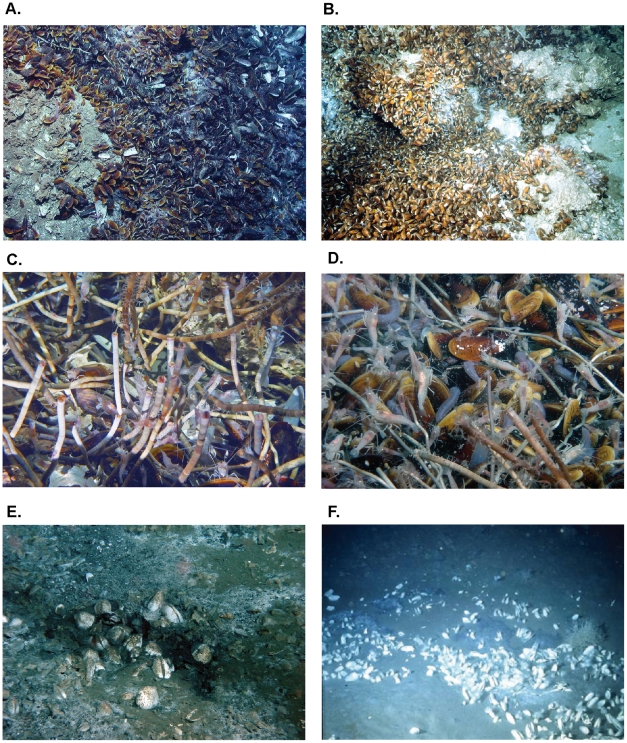
Similarities and differences among AEB cold-seep site habitats.A. Mussel bed (Bathymodiolus brooksi) from Atwater Valley at 2200m depth in the Gulf of Mexico, B. Mussel bed (Bathymodiolus childressi) on the El Pilar area, Barbados prism (1300m) (©Ifremer, Diapisub 1992), C. Mussels and tubeworms along with Alvinocaris muricola from Atwater Valley at 2200m depth in the Gulf of Mexico. (A. & C.: © MMS-NOAA OER Chemosynthetic Ecosystems study). D. Bathymodiolus aff. boomerang bed on the Regab pockmark off Congo associated with other amphi-Atlantic species (Alvinocaris muricola, Chiridota aff. heheva), and the Siboglinidae Escarpia southwardae. E. Vesicomyidae Calyptogena valdiviae and microbial mats on the Guiness area off Gabon (D. & E. ©Ifremer, Biozaire 2001). F. Vesicomyidae Calyptogena aff. kaikoi aggregate and sponges Cladorhiza methanophila in the Barbados trench. (©Ifremer, Manon 1992).